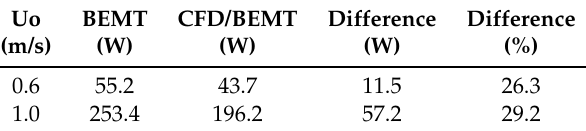
Figure 11. Generator Power for ( a ) Uo = 0.6 m/s and ( b ) Uo = 1.0 m/s. Table 8. Average turbine generator power.